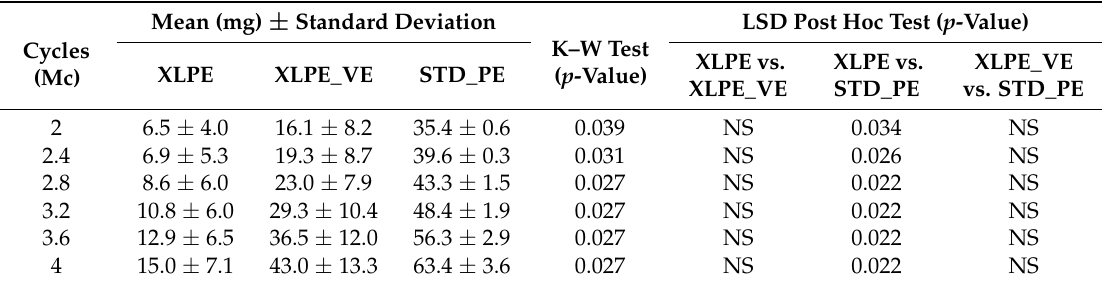
Table 3. Cumulative mass loss (±standard deviation) for the three sets of PE acetabular cups tested. The p -values were obtained using a Kruskal–Wallis nonparametric test.